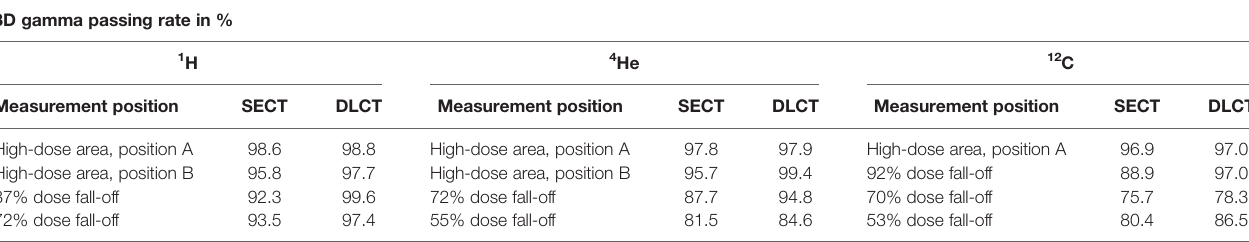
Four different depths were investigated, with two of the depths for 1 H and 4 He being in the high-dose area (positions A and B), while the second depth for 12 C was already in the dose fall-off.